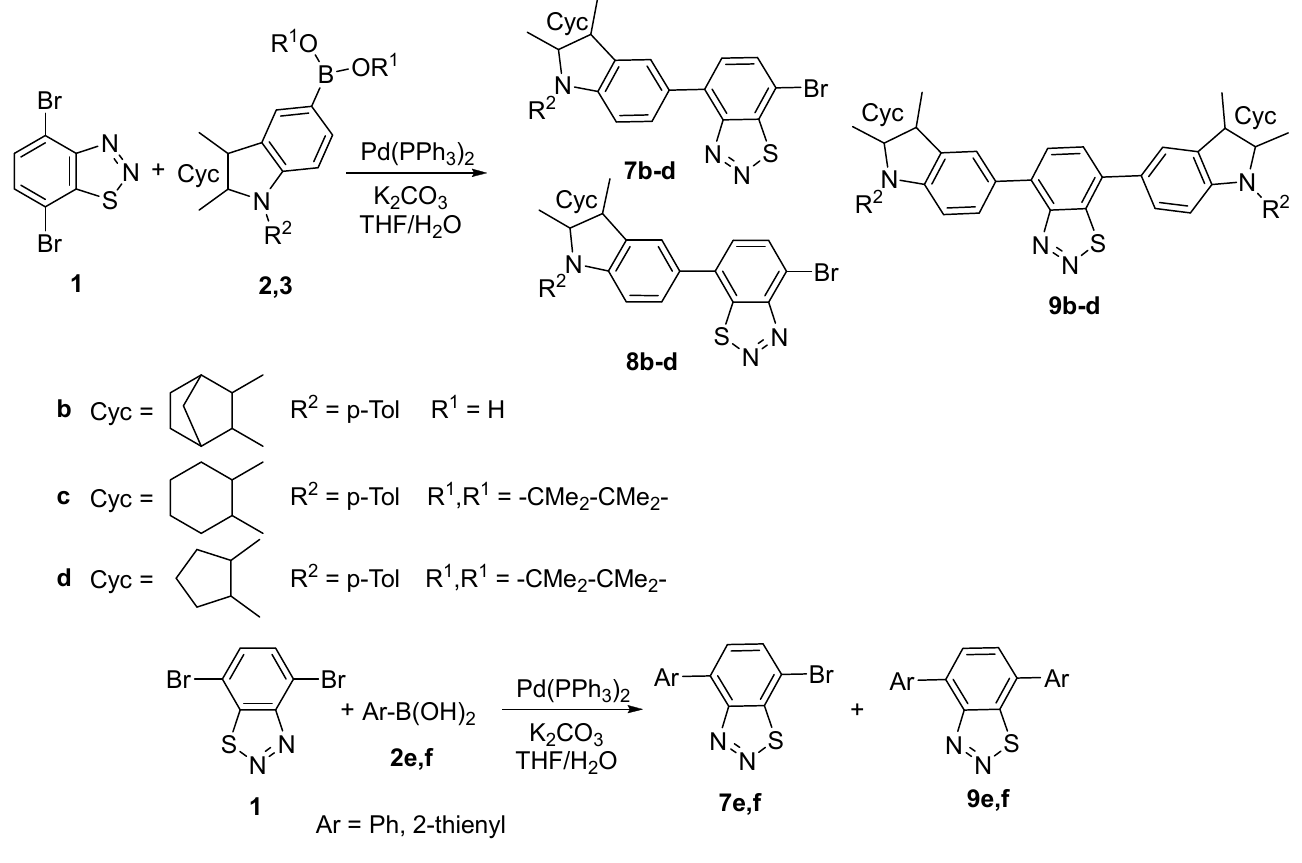
Table 2. Yields of compounds 7–9 in the Suzuki cross-coupling reactions of